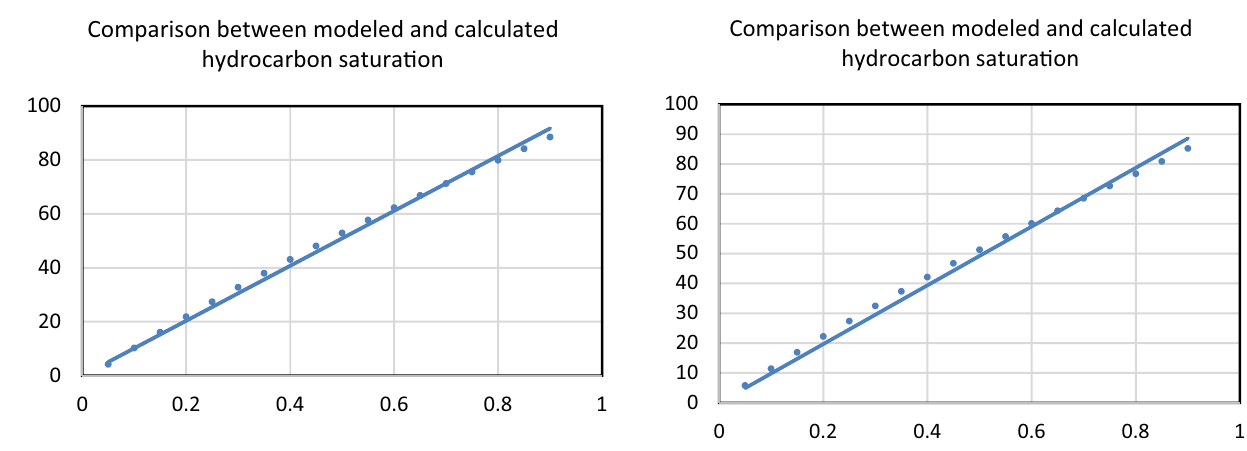
Fig. 24 Hydrocarbon saturation from density